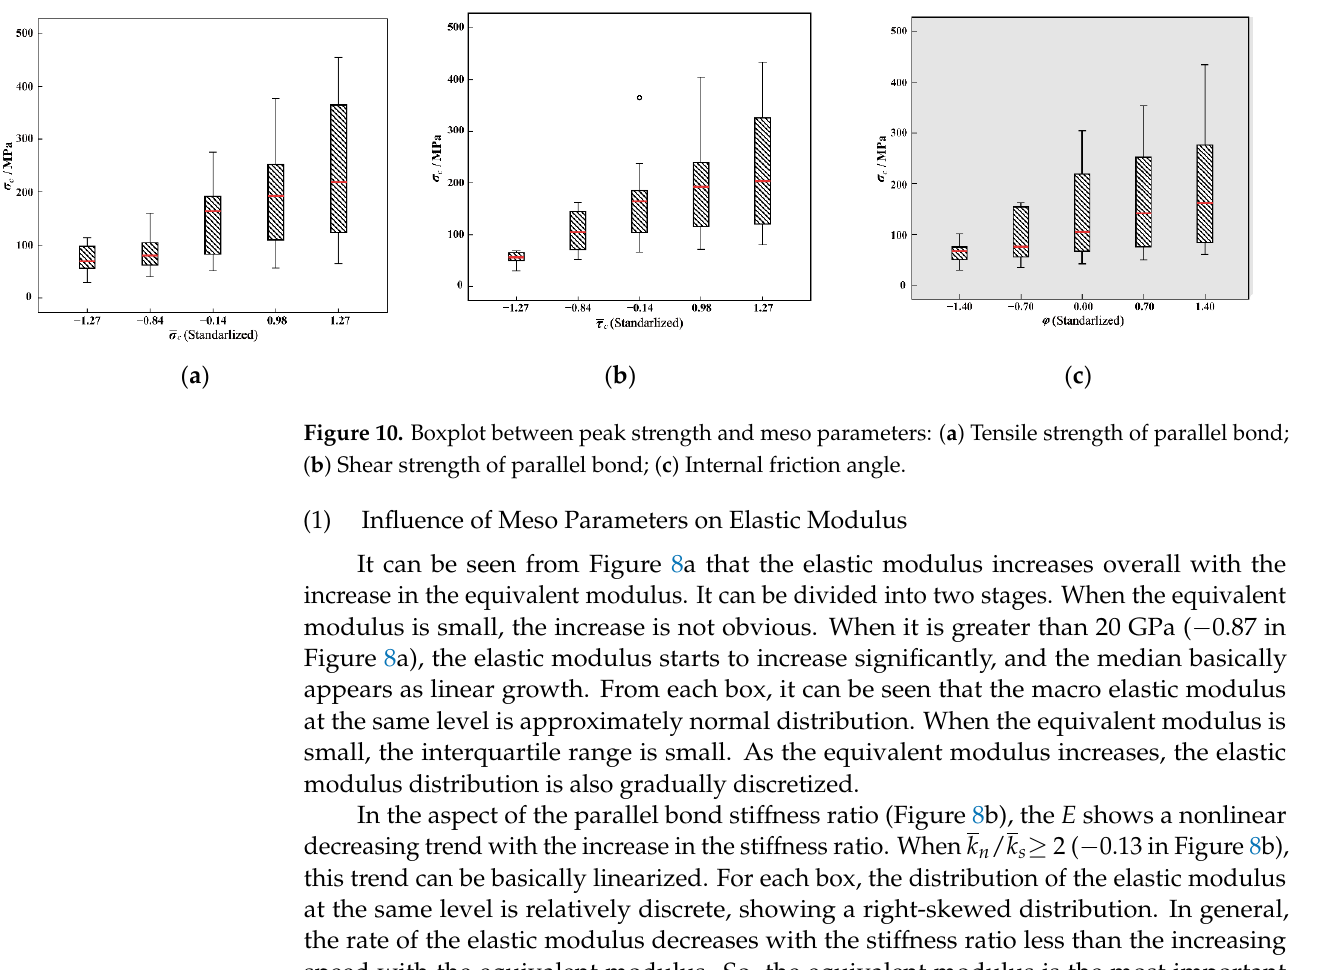
Figure 9. Boxplot between Poisson’s ratio and meso parameters: ( a ) Particle stiffness ratio; ( b ) Parallel bond stiffness ratio; ( c ) Friction coefficient.